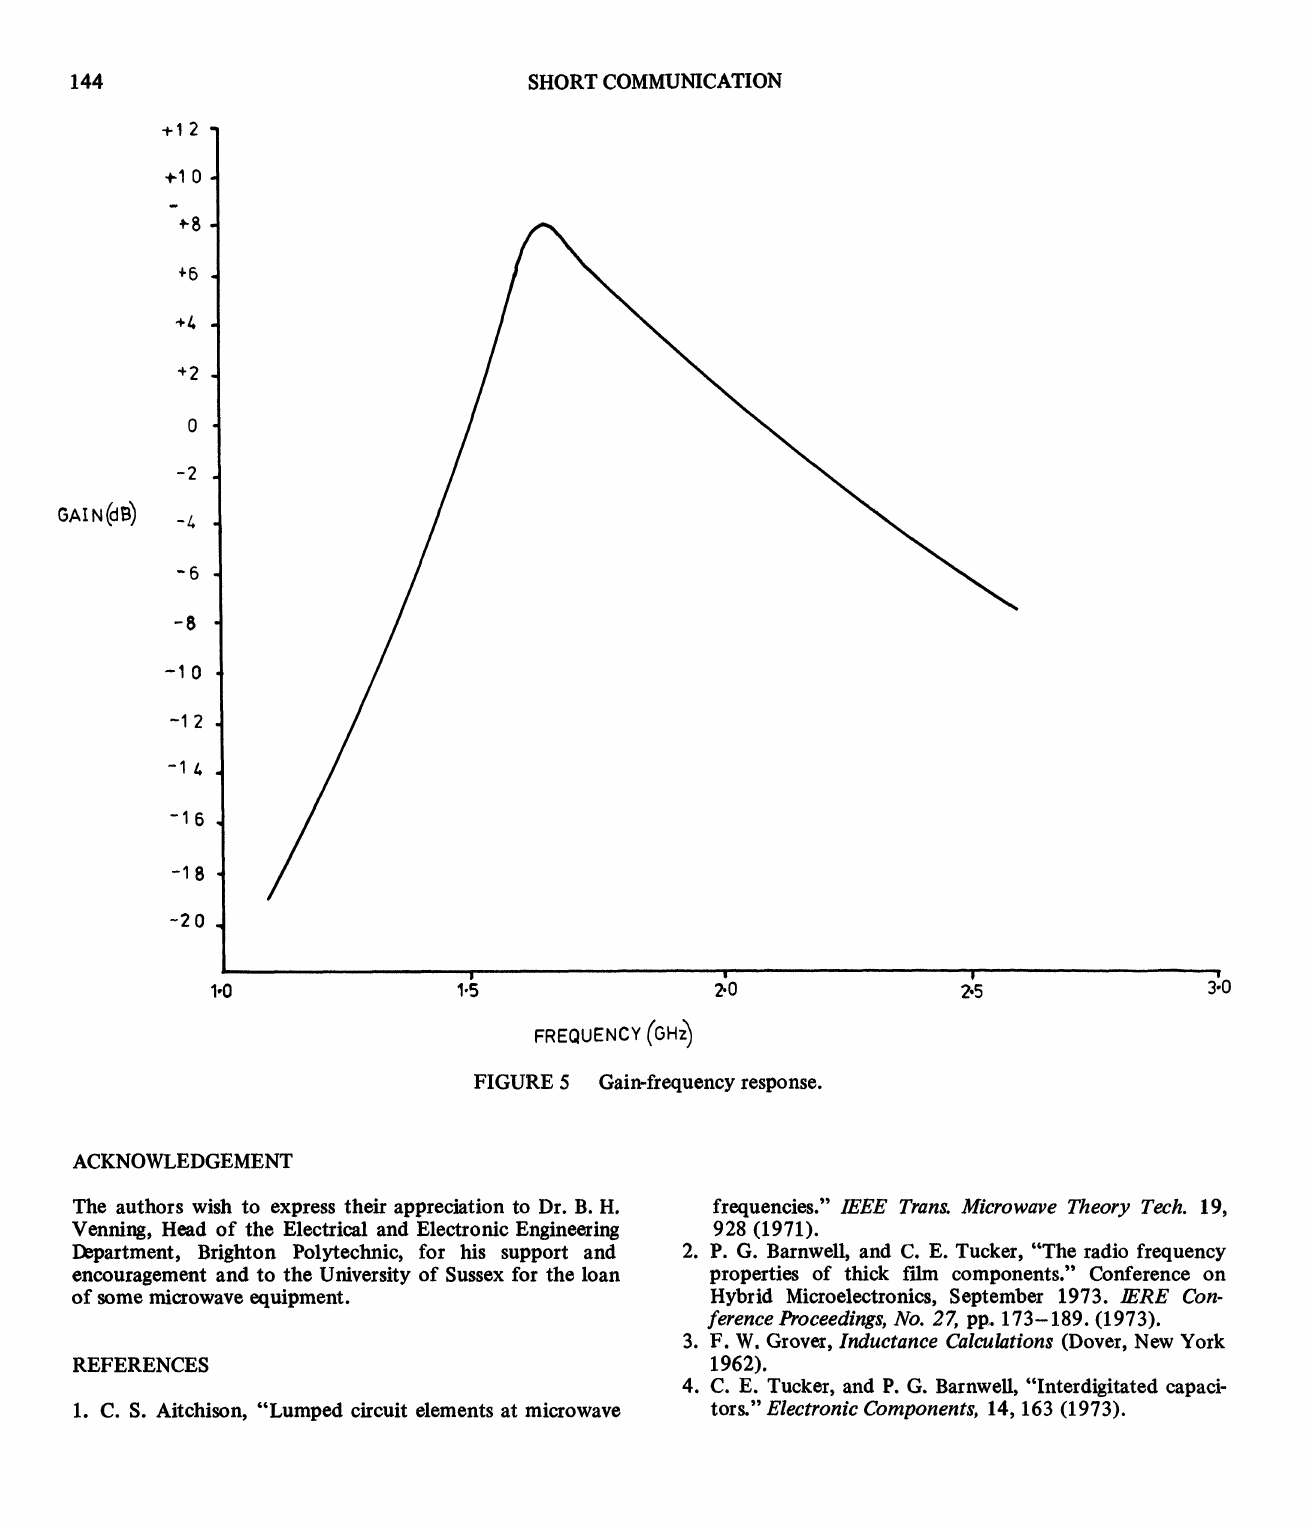
FREQUENCY (GHz FIGURE 5 Gain-frequency